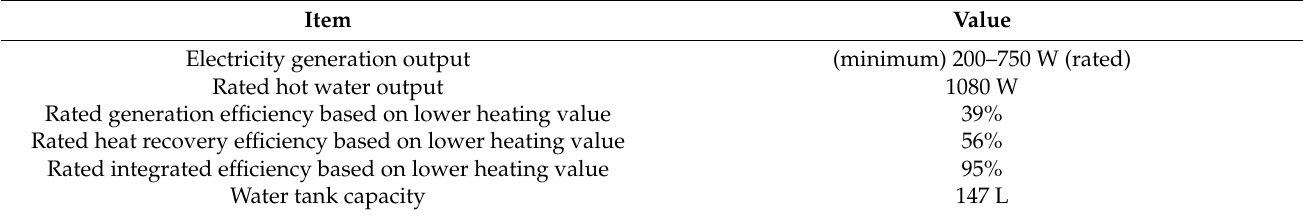
Table 1. Performance values of polymer electrolyte fuel cell cogeneration system (CGS) for a condominium. Item Value Electricity generation output (minimum) 200–750 W (rated) Rated hot water